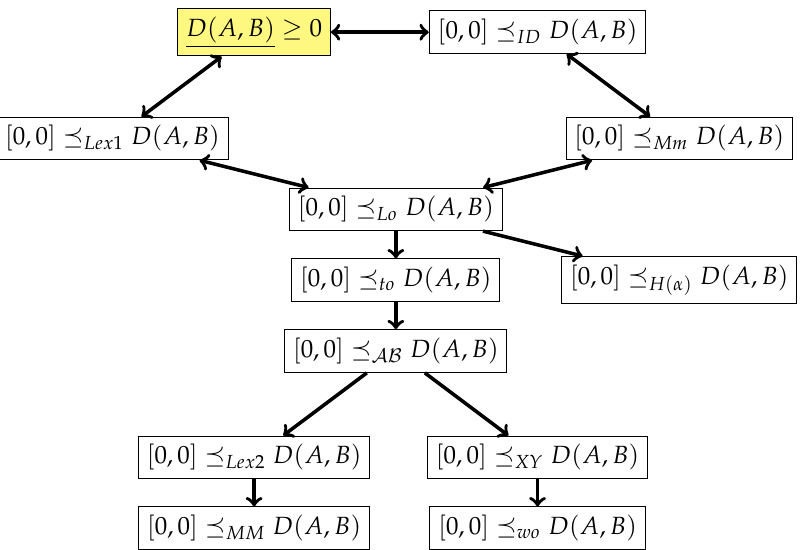
Figure 11. Non-negativity for different